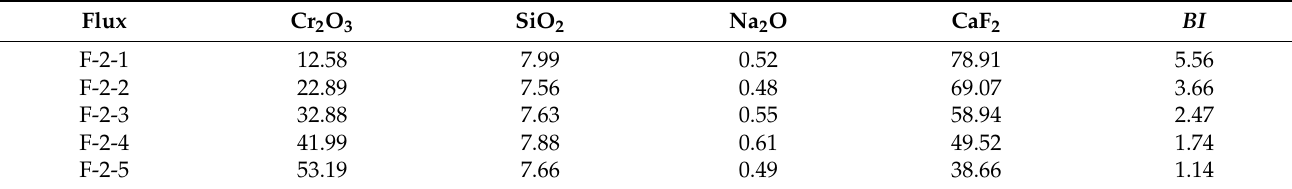
Table 2. Flux formulas subject to CaF 2 -SiO 2 -Na 2 O-Cr 2 O 3 fluxes [28].